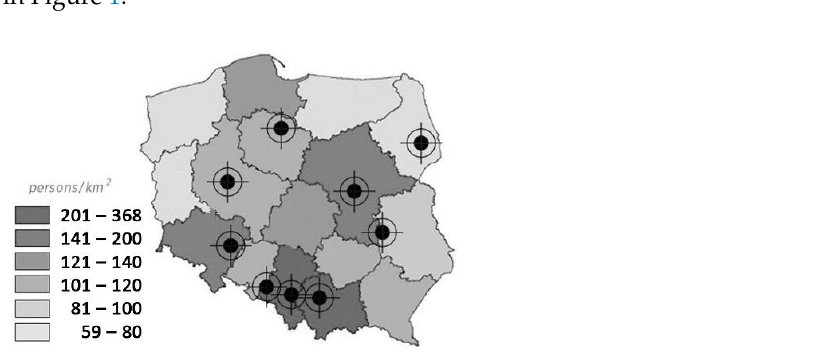
Figure 1. Map of Poland with marked Covidium hospitals, including population density in each voivodeship (region).